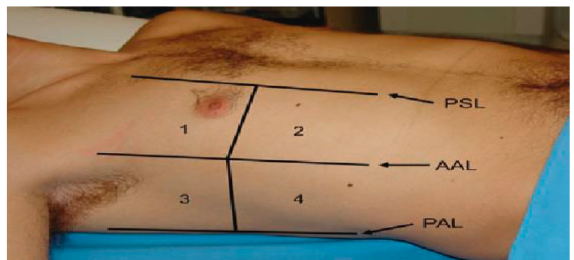
Figure 1: Areas of chest wall examination by ultrasound. PSL: parasternal line; AAL: anterior axillary line; PAL: posterior axillary line